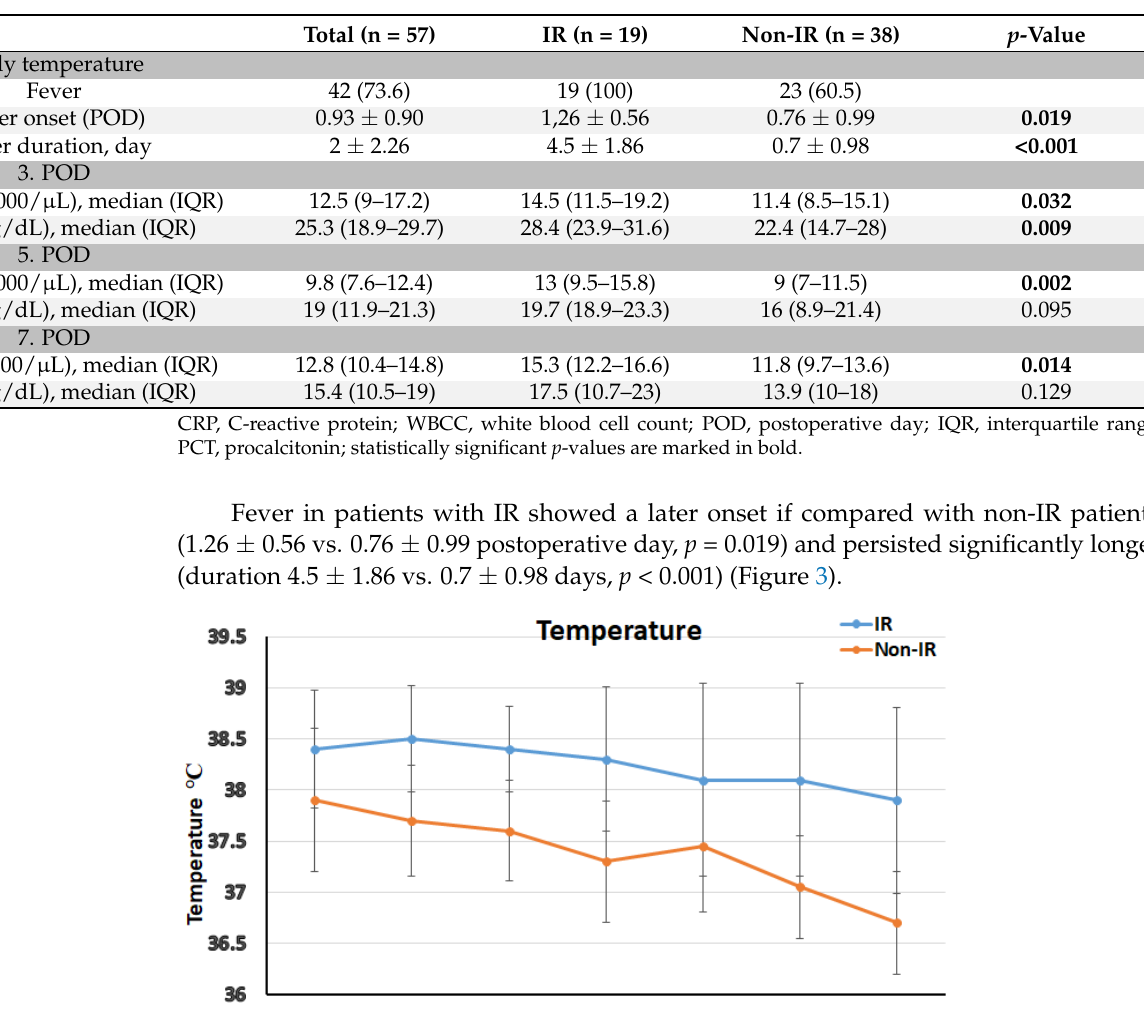
Figure 2. Box plot representing preoperative and postoperative thrombus volume. Table 3. Postoperative inflammatory markers in the whole population and divided according to the presence of IR.